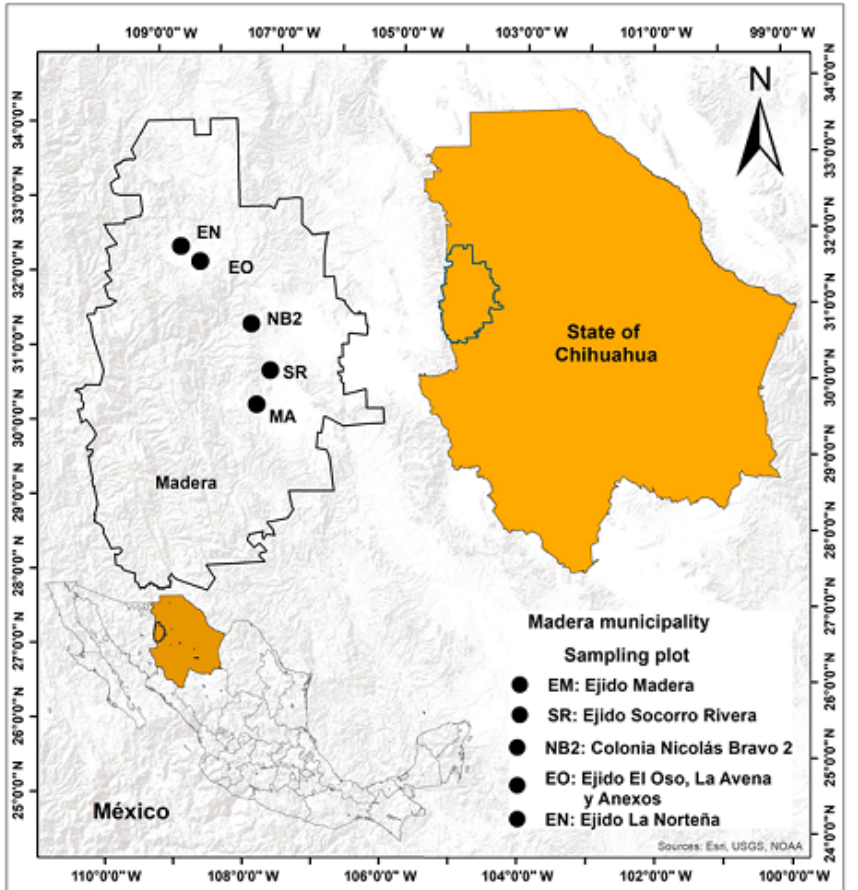
Figure 1. Location of the five 100 × 100 m (1 ha) sampling plots in the municipality of Madera, Chihuahua, Mexico. Source: Own elaboration using ArcGis software available at Esri, DigitalGlobe, GeoEye, Earthstar Geographics, CNES/Airbus DS, USDA, USGS, AEX, Getmapping, Aerogrid, IGN, IGP, swisstopo, and the GIS User Community). Maps were created using ArcGIS® software by Esri. Copyright ©Esri. All rights reserved [45]. Table 1. Geographical coordinates of the plot samples in the study area. Plot Geographical Coordinates